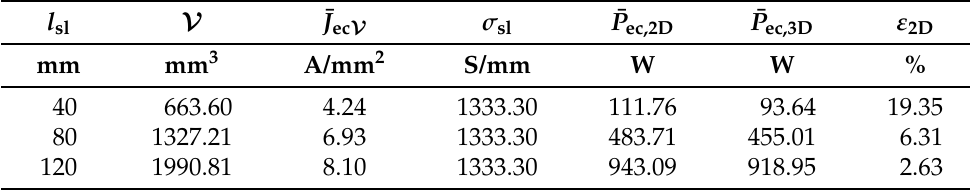
Table 4. A comparison of 2D and 3D no-load simulation results at